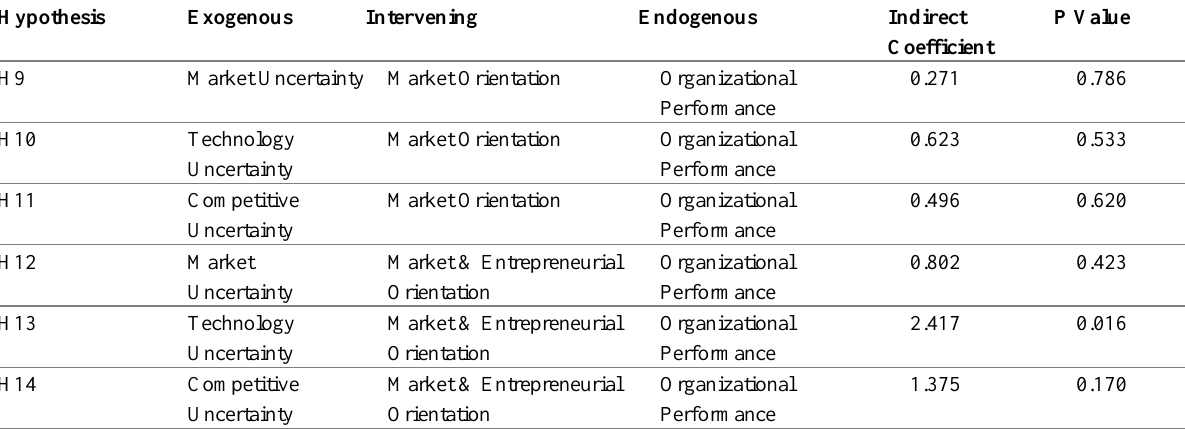
Table 3: Results of Indirect Effect Hypothesizes